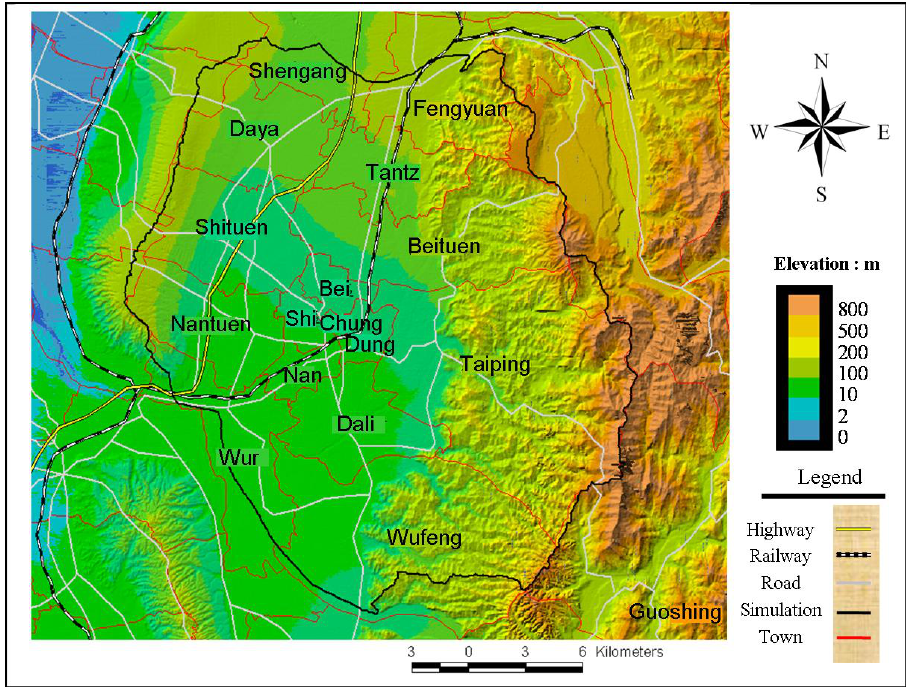
Figure 16. Elevation, water system, and sewer manholes of Taichung city.